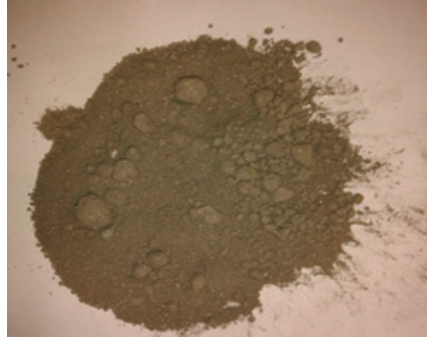
Figure 1. Desulfurized slag.